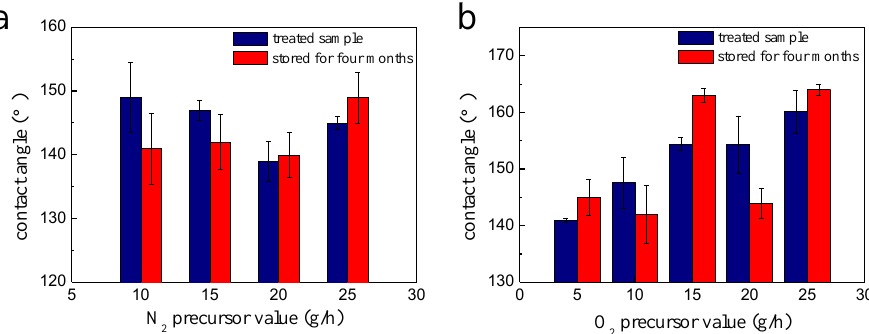
Figure 10. The durability of N 2 plasma-treated cotton fabric ( a ) and O 2 plasma-treated cotton fabric ( b ) after stored for four months.